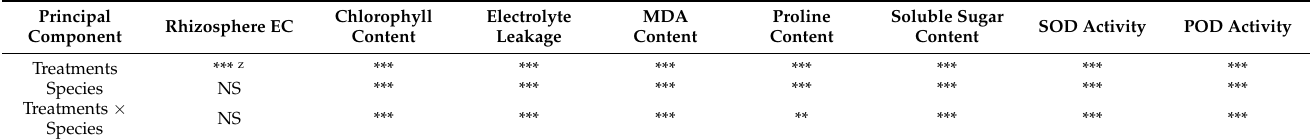
Table 5. Two-way ANOVA analysis between rhizosphere EC, chlorophyll content, electrolyte leakage, MDA content, proline content, soluble sugar content, SOD activity, POD activity and principal component.